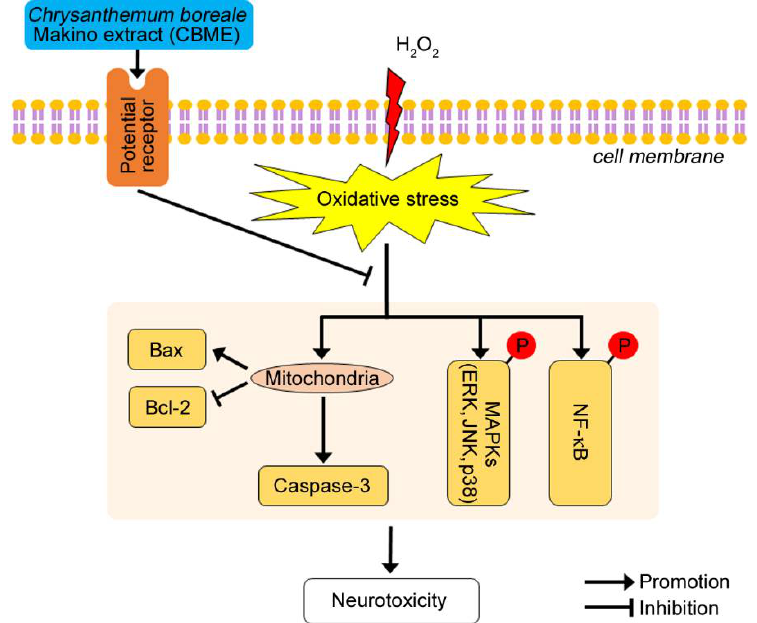
Figure 7. A schematic diagram illustrating the proposed protective mechanism of CBME against oxidative stress. CBME protects neuronal cells against H 2 O 2 -induced cell death by preventing caspase-3 activation, Bax upregulation, Bcl-2 downregulation, MAPK-regulated apoptotic cell loss, and NF-κB-mediated inflammation.